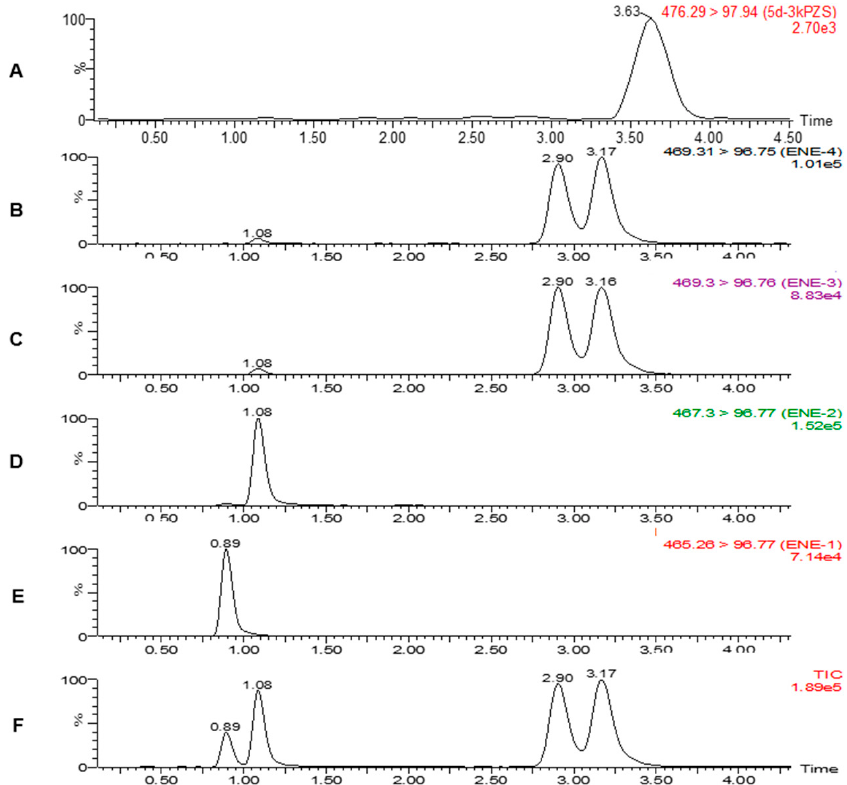
Figure 2. Chromatograms of ( A ) [ 2 H 5 ]-3kPZS, with transition 476 > 97; ( B ) 1-ene 3kPZS with transition